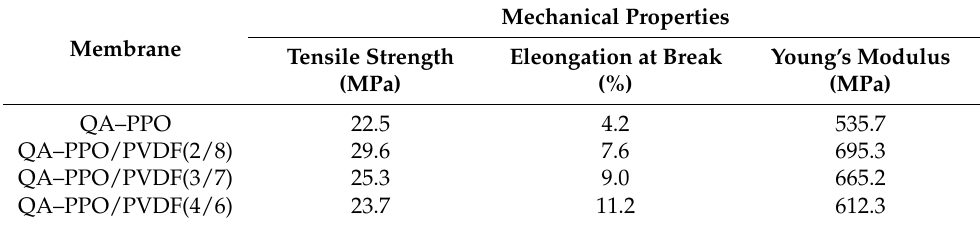
Table 1. Mechanical properties of BAEMs.